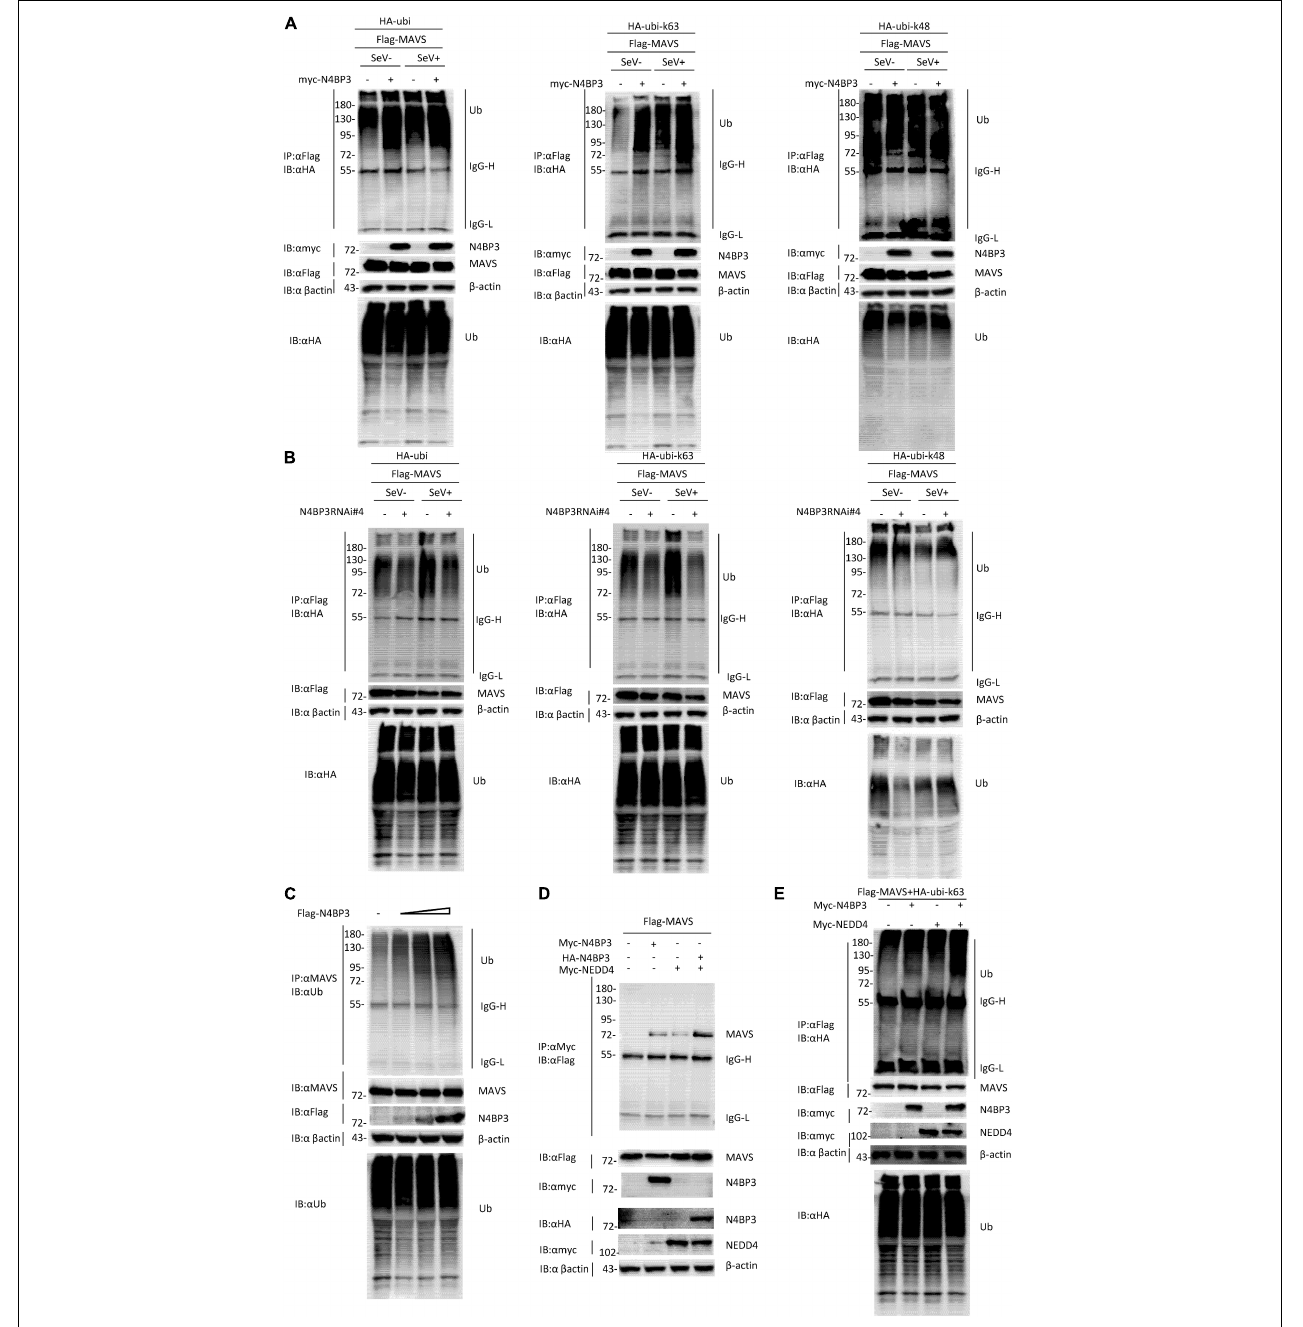
FIGURE 4 | N4BP3 promotes the polyubiquitination of MAVS. (A) N4BP3 promotes the polyubiquitination of MAVS. 293T cells were transfected with the indicated plasmids. After 12 h of transfection, the cells were stimulated with or without SeV for 12 h, and the cells were collected and lysed. The indicated antibodies were used for co-immunoprecipitation and immunoblotting analysis. Most lysates are used for anti-Flag beads immunoprecipitation and western blotting analysis with anti-HA antibodies. A small portion of the lysate is used for routine western blotting to check the expression of each plasmid. (B) N4BP3 knockdown prevents MAVS polyubiquitination. The methods of co-immunoprecipitation and immunoblotting were like panel (A) . (C) N4BP3 promotes endogenous MAVS ubiquitination. 293T transfected with the indicated plasmids. 24 h after transfection, cell lysates were immunoprecipitated with anti-MAVS. The immunoprecipitates were analyzed by immunoblots with anti-ubiquitin, anti-MAVS, or anti-Flag as indicated. (D) NEDD4 enhances the interaction between MAVS and N4BP3. 293T transfected with Flag-tagged MAVS, in the presence or absence of Myc-tagged N4BP3, Myc-tagged NEDD4, and HA-tagged N4BP3 for 24 h, followed by co-immunoprecipitation and immunoblotting analysis with the indicated antibodies. (E) NEDD4 promotes the ubiquitination of MAVS by N4BP3. The N4BP3, NEDD4 plasmids, and other plasmids were transfected into 293T cells, and after 20 h, the cells were collected and lysed. The methods of co-immunoprecipitation and immunoblotting were like panel (A)